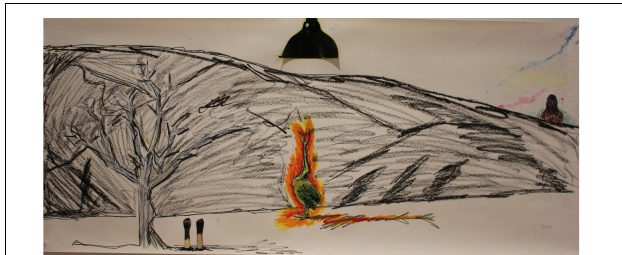
FIGURE 2 | Participant artwork: “Phoenix that does not